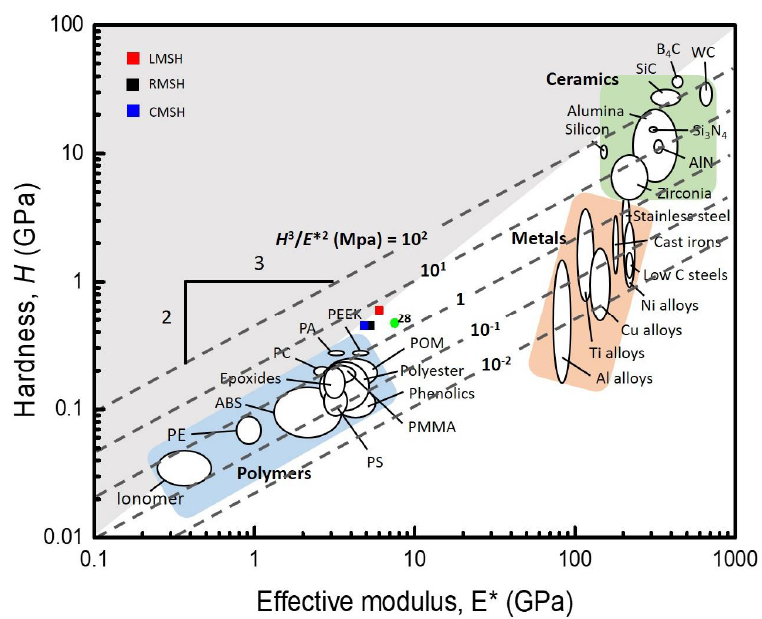
Figure 4. Mechanical properties of LMSH, RMSH, and CMSH with nano-indentation test. ( a ) Load versus indenter displacement for the methacrylate siloxane hybrid materials; ( b ) SEM images of the LMSH during nano-indentation test. The green dashed line is indicated the loading area, the impression is almost recovered after nano-indentation test (Video S1); ( c ) a plot of effective modulus and hardness data, in situ calculated during nano-indentation test; ( d ) a plot of the elastic recovery versus hardness-to-effective modulus ratio. The elastic recovery is derived by integrating the graph.